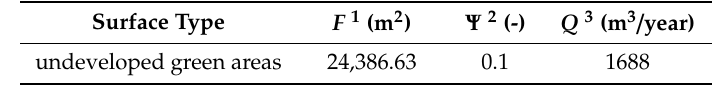
Table 3. Runo ff volume before the completion of the investment.